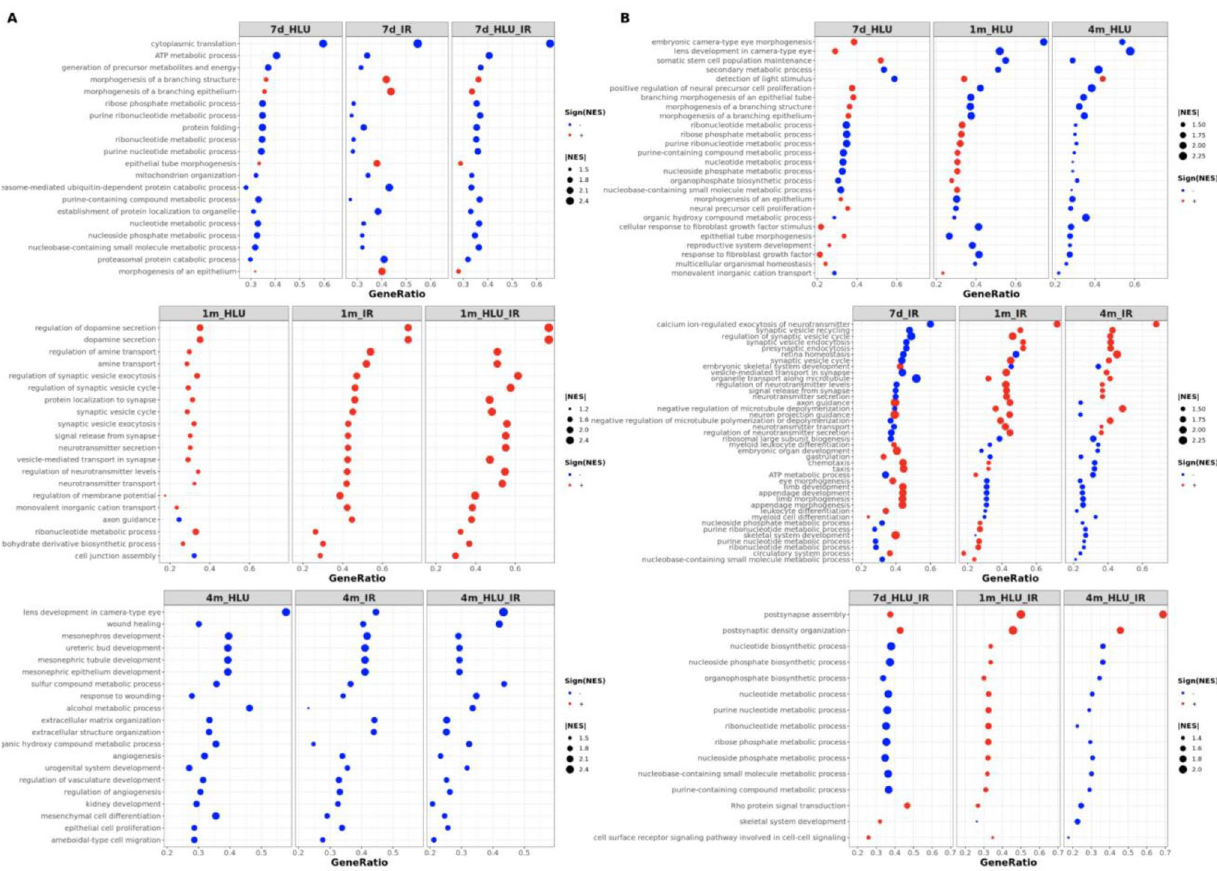
Figure 3. Common biological processes enriched in different exposure groups and at different time points. (A) Top 20 significantly enriched BP common across all exposure conditions for a given time point. (B) Significantly enriched BP common across all time points for a given exposure condition. Size of each point represents magnitude of normalized enrichment score (NES) while the color indicates activation (red) or suppression (blue) of the BP in the given exposure group compared to time point-matched controls. The Y-axis provides a description of common GO BP and the X-axis lists the ratio of genes that belong to a given gene set to the total number of genes in the gene set. ClusterProfiler was used for gene set enrichment analysis and the R package ggplot2 was used for visualization. BP biological processes, HLU hindlimb unloading, IR irradiation, NES normalized enrichment